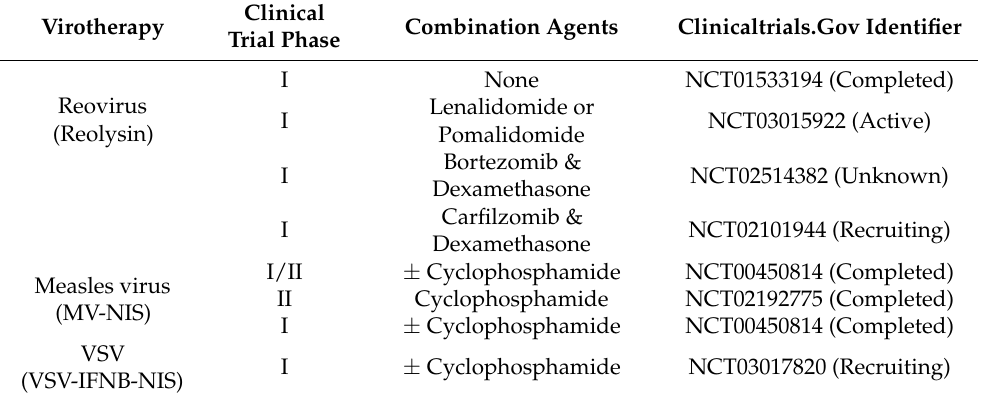
Table 2. Clinical trials of oncolytic virotherapy in multiple